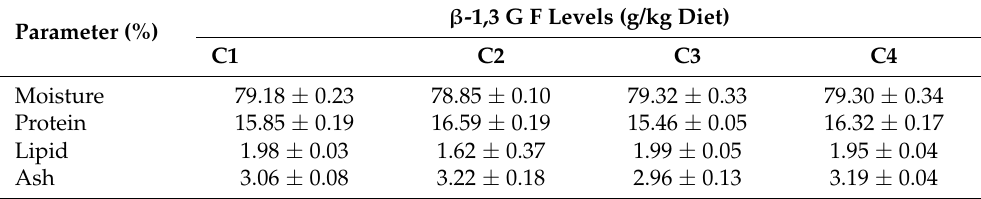
Table 3. Proximate chemical composition (% on a dry matter basis) of muscles of Pacific white shrimp, Litopenaeus vannamei , fed various concentrations of β -1,3 glucan and Fructooligosaccharides for 75